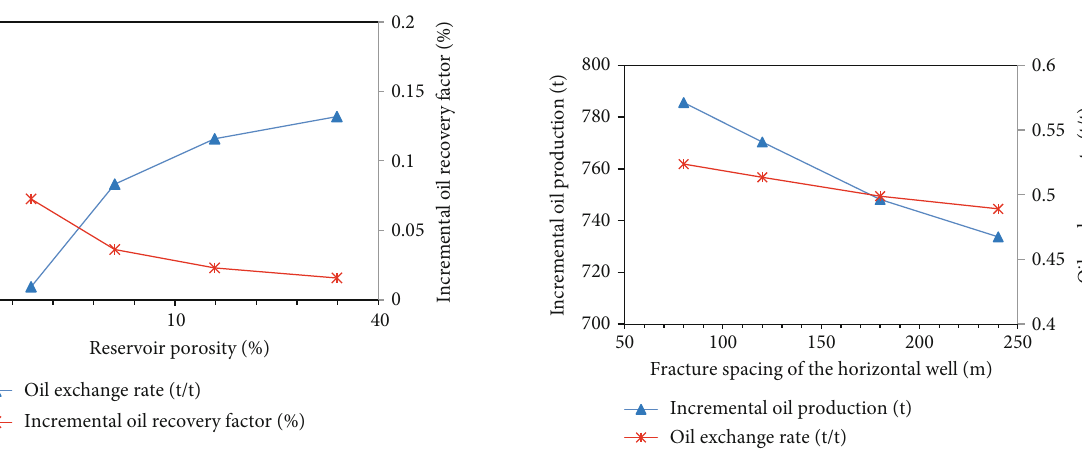
Figure 10: Oil exchange rate and incremental oil recovery through CO hu ff -n-pu ff under di ff erent reservoir porosity. 2